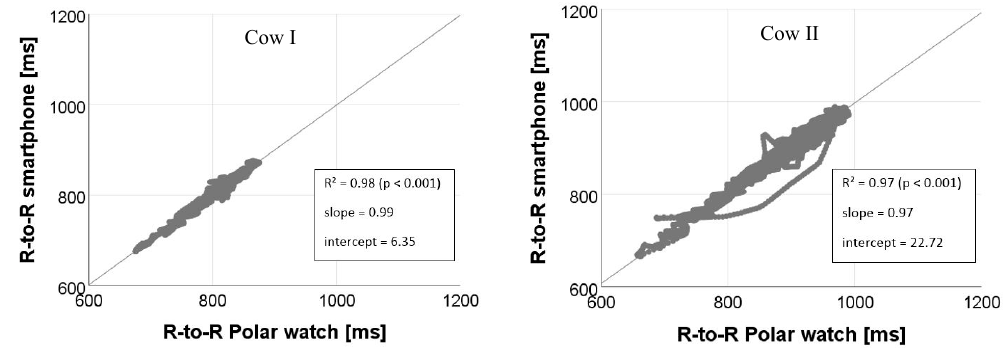
Figure 8. Relationships between RR intervals (R-to-R) (ms) derived from the smartphone IoTool application and Polar watch V800 for measurements of Cow I and Cow II.